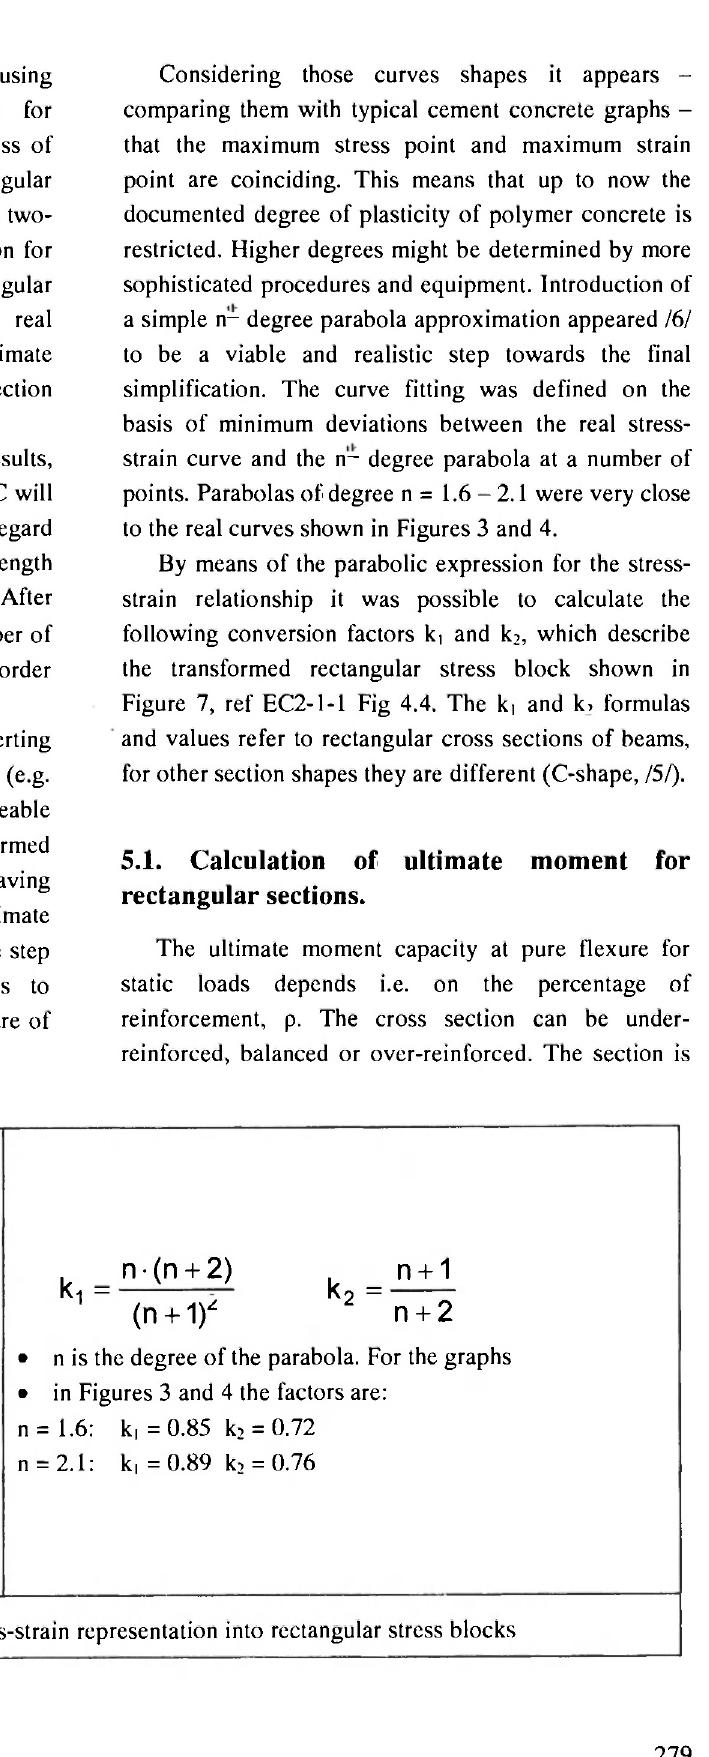
Fig. 7: Converting parabolic stress-strain representation into rectangular stress